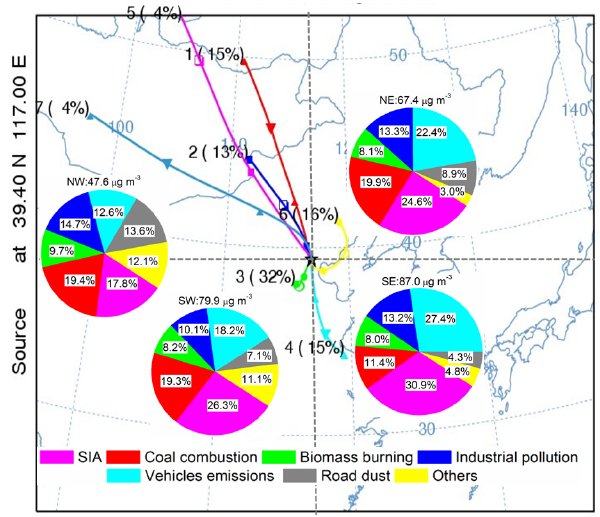
Figure 8. Relative contributions from each identified source to PM 2 . 1 at different trajectory